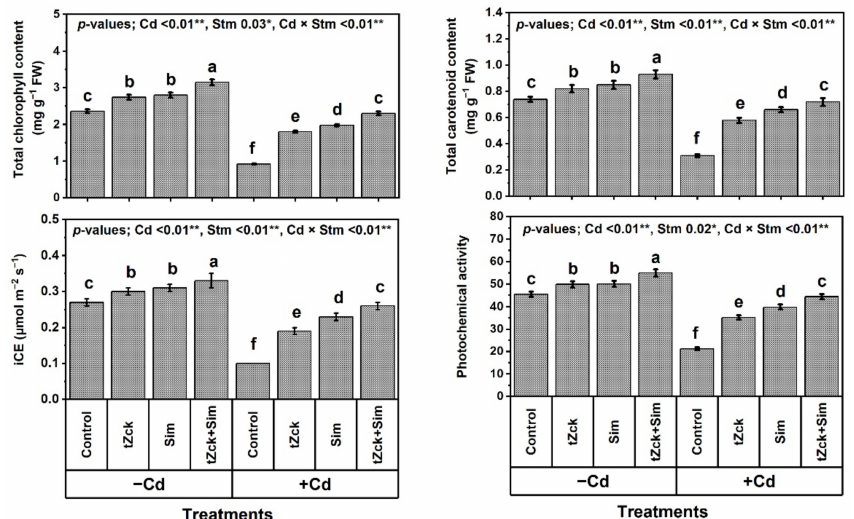
Figure 3. Leaf photosynthetic efficiency (total chlorophyll and carotenoid contents, instantaneous carboxylation efficiency; iCE, and photochemical activity) of wheat (cv. Sakha 93) treated with two stimulators (Stm) i.e., silymarin (Sim; 0.5 mM) and trans -zeatin-type cytokinin ( t Zck; 0.05 mM) under cadmium (Cd; 0.6 mM) stress. The same letters with mean values ± SE in each plot indicate non-significant differences based on the LSD test ( p ≤ 0.05). * and ** refer to significant difference at p ≤ 0.05 and p ≤ 0.01, respectively. t Zck; trans -zeatin-type cytokinin, Sim; silymarin, − Cd; without cadmium treatment, +Cd; cadmium treatment and Stm; stimulator.